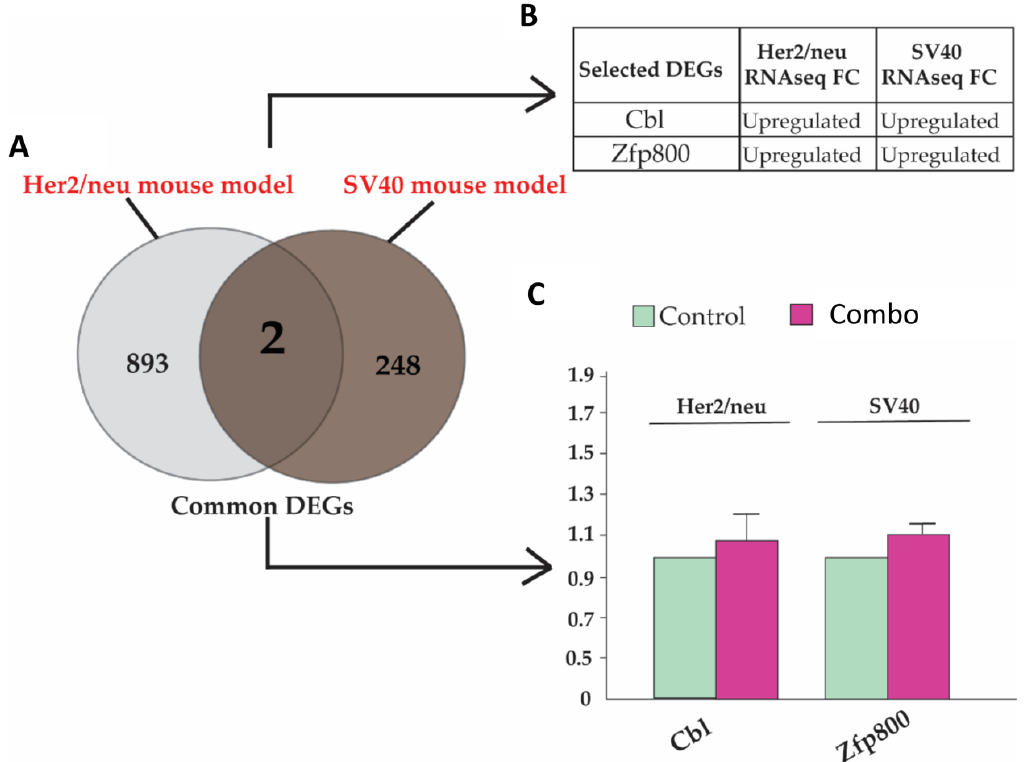
Figure 4. DEGs in the SV40 and Her2/neu mouse models. ( A ) Venn diagram of DE genes between the SV40 and Her2/neu mouse models. A total of 895 and 250 DEGs were identified in Her2/neu (gray) and SV40 (brown) mouse models, respectively. Among these, two DEGs were identified in both strains. ( B ) The table shows gene expression patterns of these common DEGs across two different mouse models. ( C ) qRT-PCR validation of gene expression of Cbl and Zfp800 in both mouse models. Values are expressed as each gene normalized on the expression of respective control (mean ± SE in three replicates).